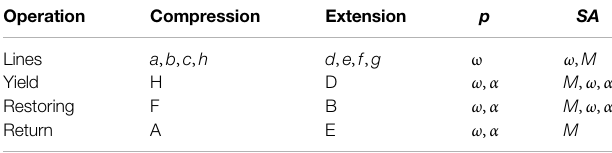
TABLE 7 | FV line diagram for the p and SA cases.